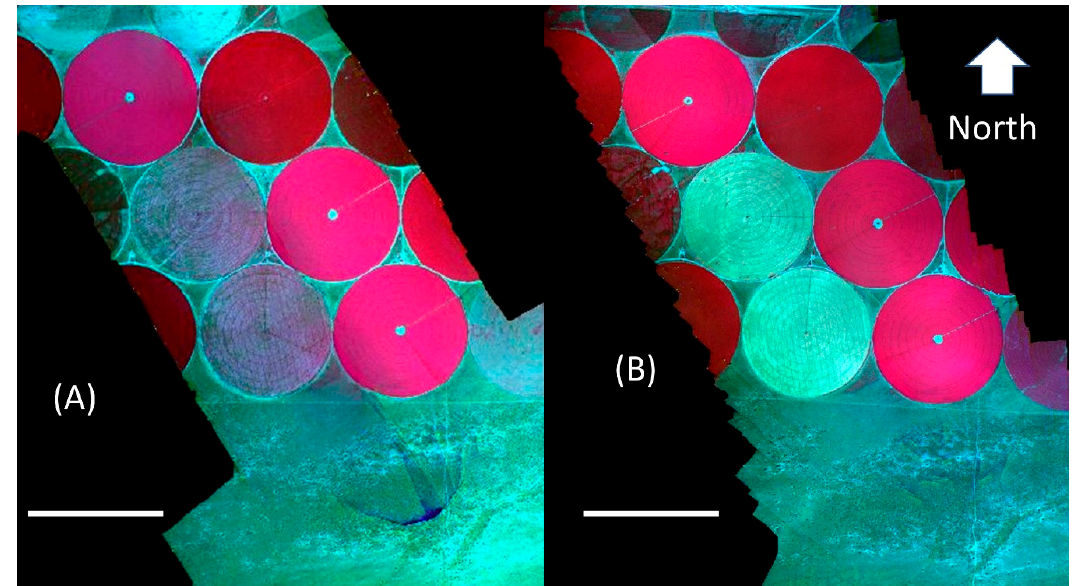
Figure 3. Figure 3. ( A ) Color-infrared orthomosaic image from the 8 July 2014 UAS flight at 1800 m AGL. ( B ) Color-infrared orthomosaic image from the 21 July 2014 UAS flight at 1800 m AGL. Crop type and UAS flight directions are shown in Figure 1.